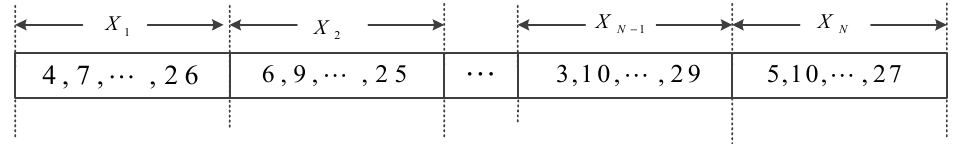
Figure 1. An example of a chromosome.